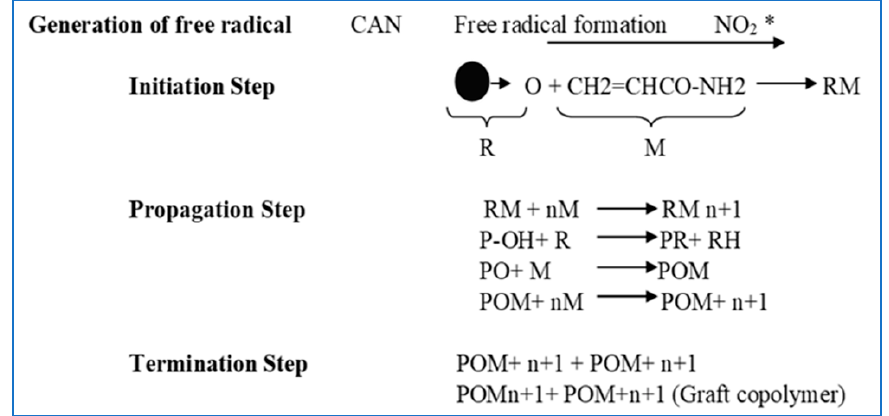
Figure 1. Schematic diagram of polyacrylamide grafting. Various characteristics of grafted tamarind seed polymer is summarised in Table